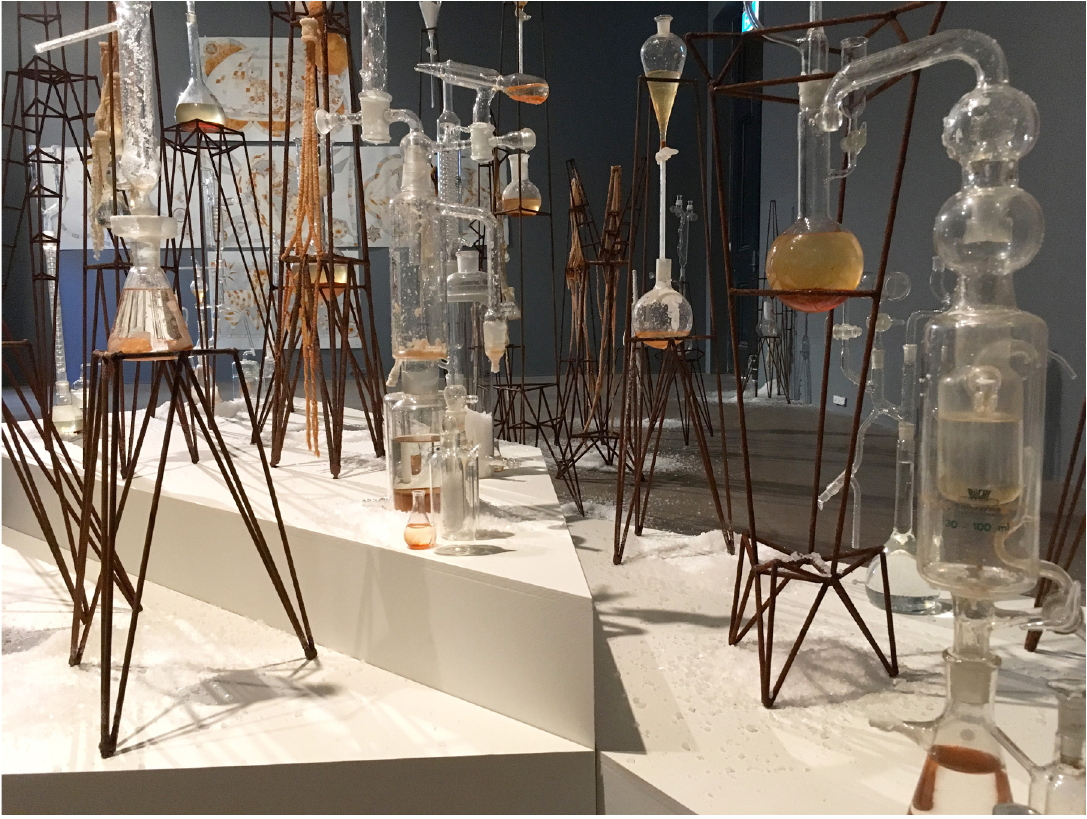
Figure 9: Tracey Clement, Metropolis Experiment (detail), 2016-18, rusty steel, lab glass, salt, cotton, dimensions variable, max height 200